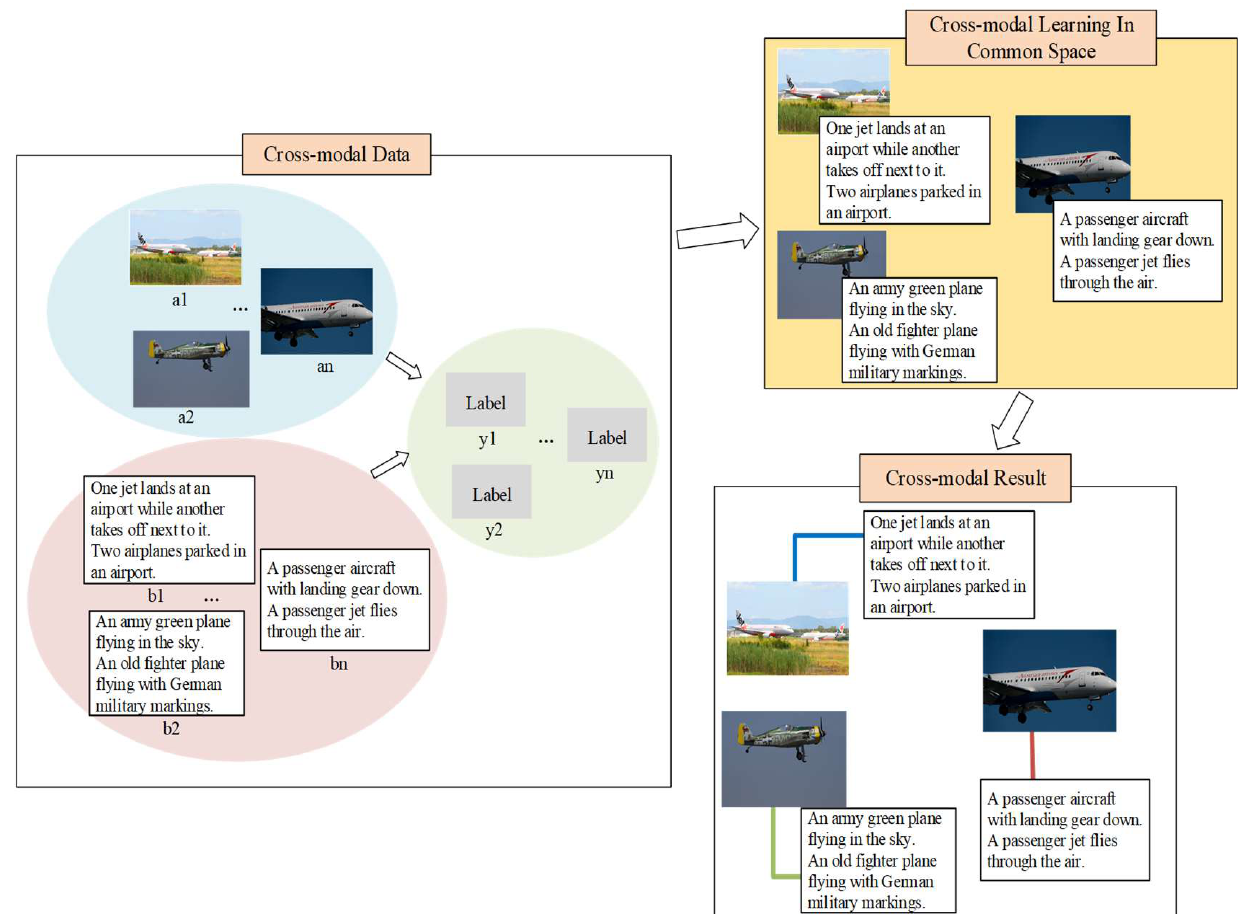
Figure 1. The cross-modal retrieval task includes image retrieving text and text retrieving images.